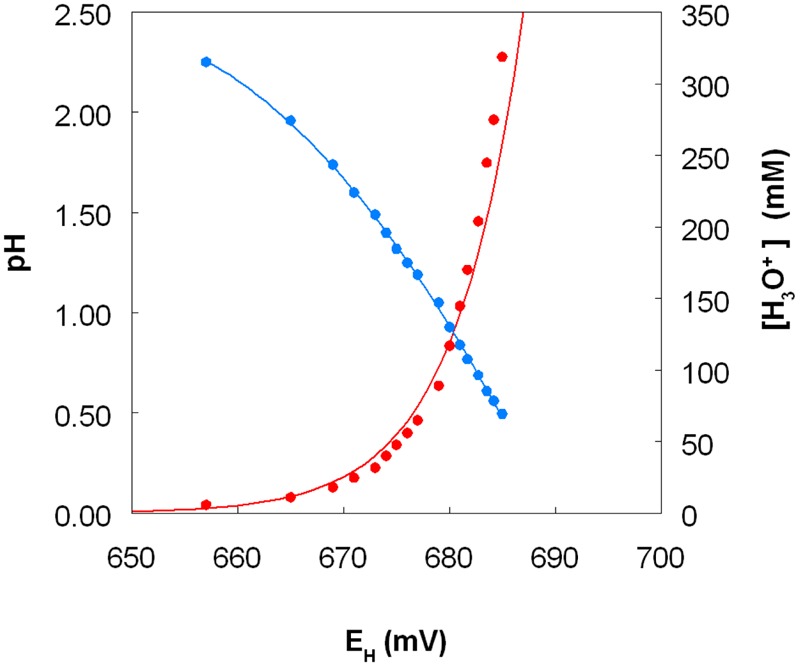
Variation of the measured standard redox potential of the iron (II)/iron (III) couple measured in acidic sulfate-rich solutions as a function of pH (in blue) and as a function of calculated proton (hydronium ion) concentration (in red).